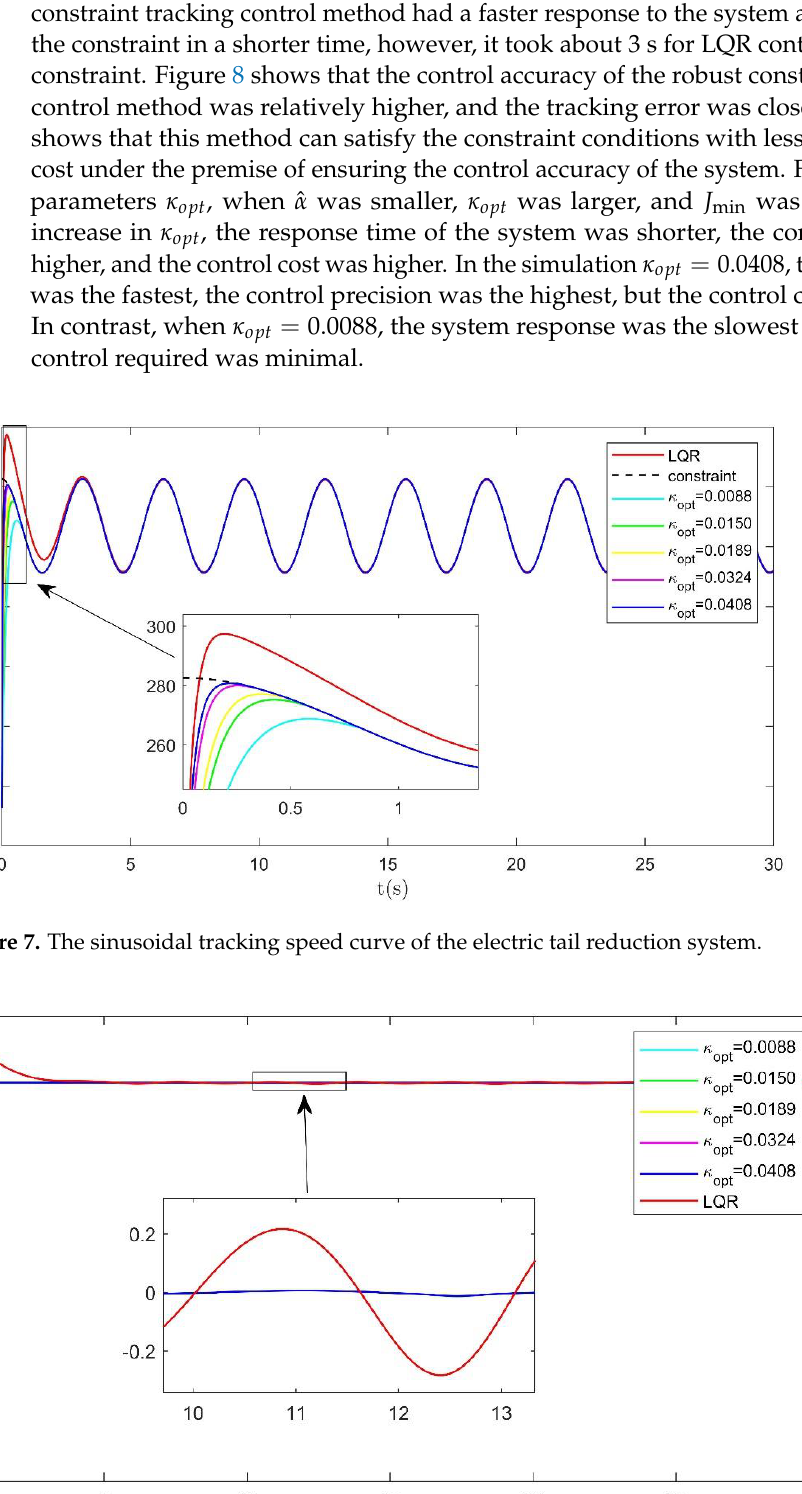
18 of 22 Table 3. Weighting factor/optimal parameter/minimum performance index. ˆ 